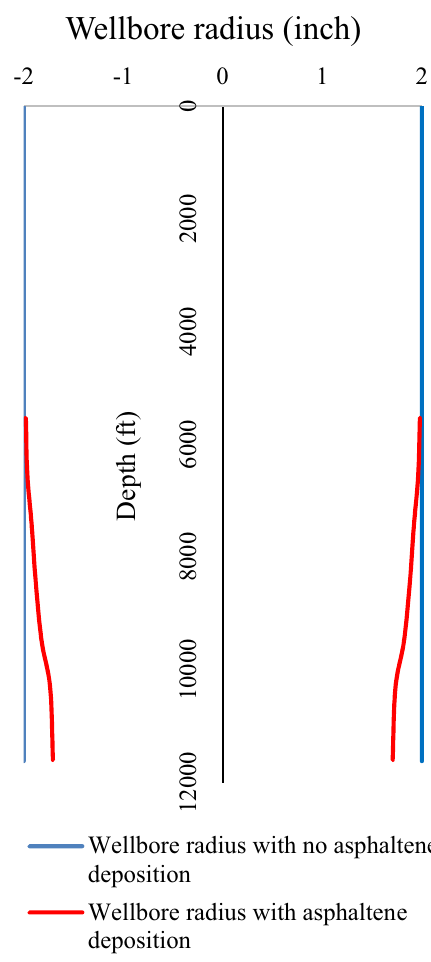
Fig. 15 Thickness of deposited asphaltene on tubing surface in